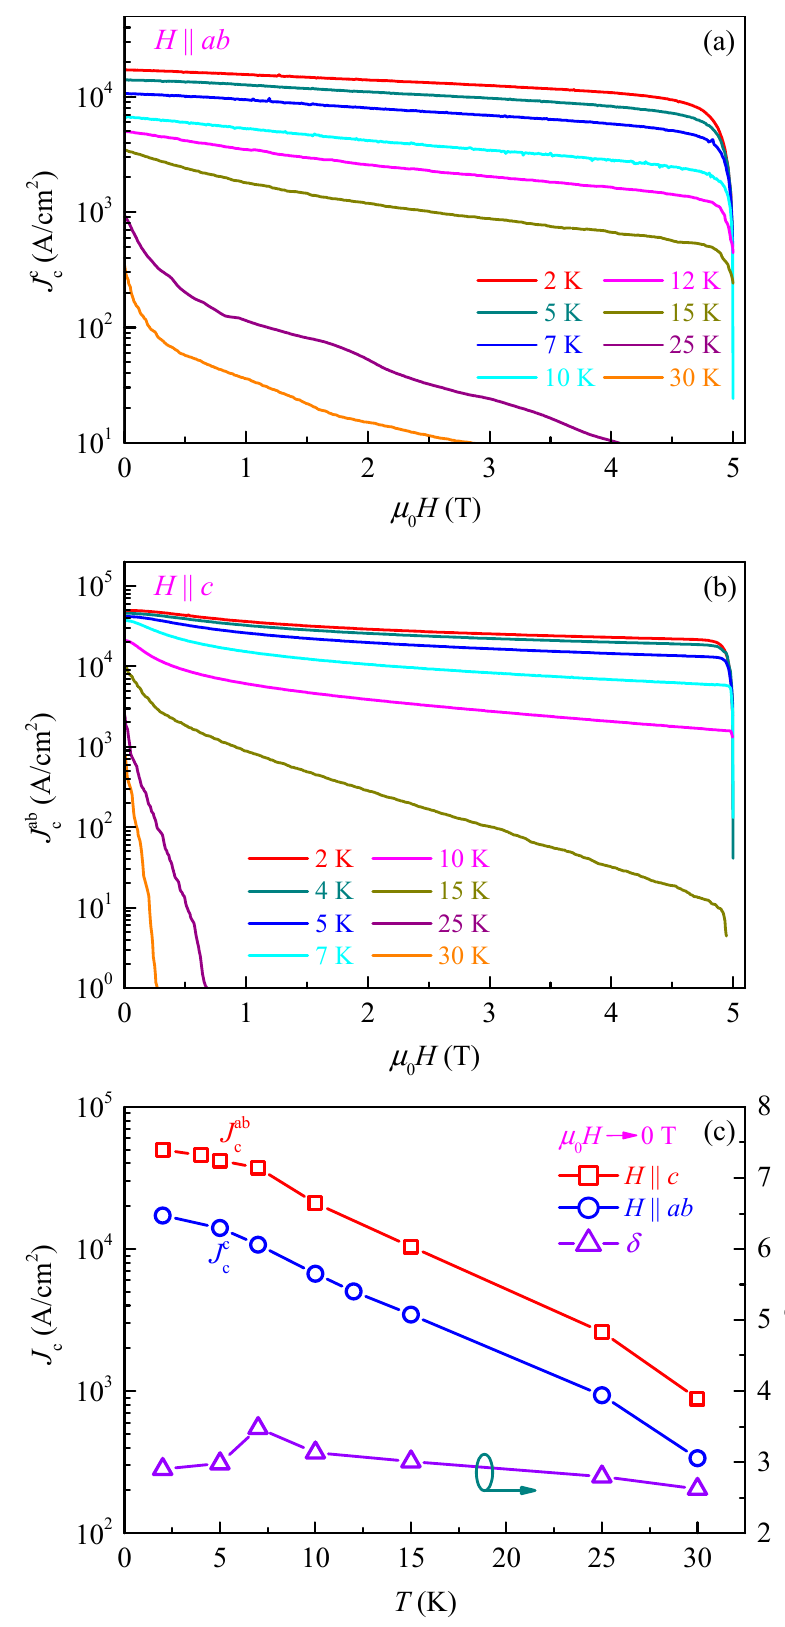
Figure 17. μ 0 H dependence of ( a ) (cid:1836) (cid:2913)(cid:2913) and ( b ) (cid:1836) (cid:2913)(cid:2911)(cid:2912) at different temperatures; ( c ) J c - T and δ - T relations Figure 17. µ 0 H dependence of ( a ) J c c and ( b ) J ab c at different temperatures; ( c ) J c - T and δ - T relations in in the temperature range 2–30 K, 2.62 ≤ δ ≤ 3.48. the temperature range 2–30 K, 2.62 ≤ δ ≤